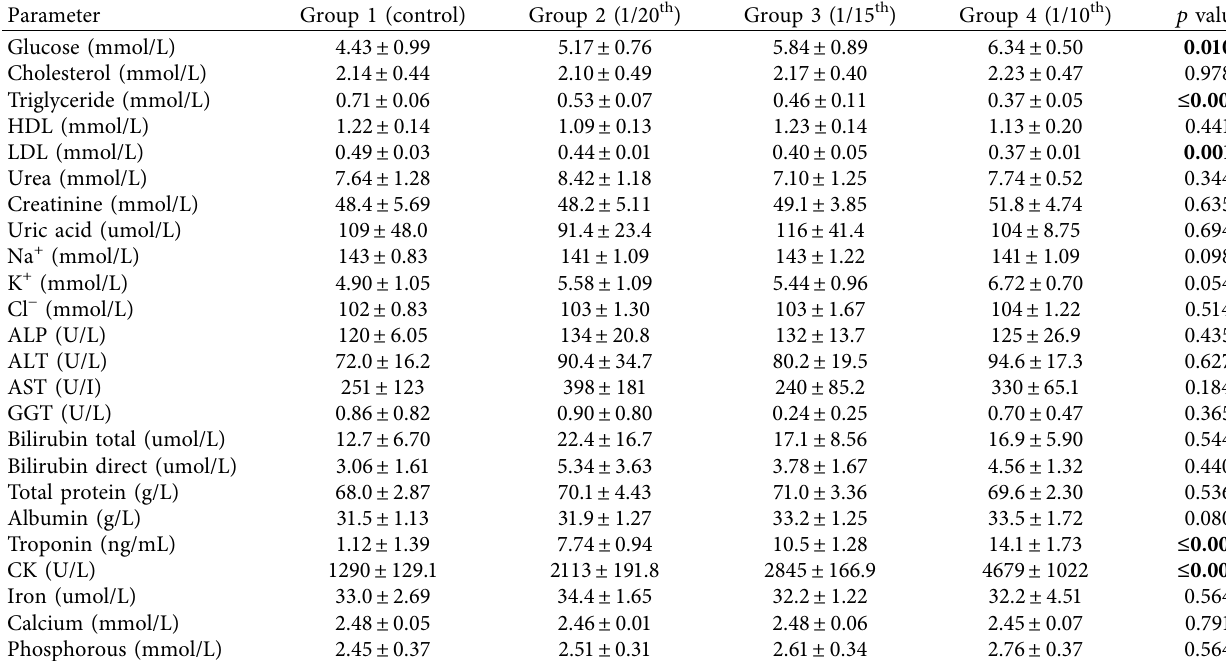
Table 4: Values of biochemical parameters and their statistical analysis compared to control in Sprague Dawley male rats supplemented with A. syriaca extract at 1/20 th , 1/15 th , and 1/10 th doses of LD 50